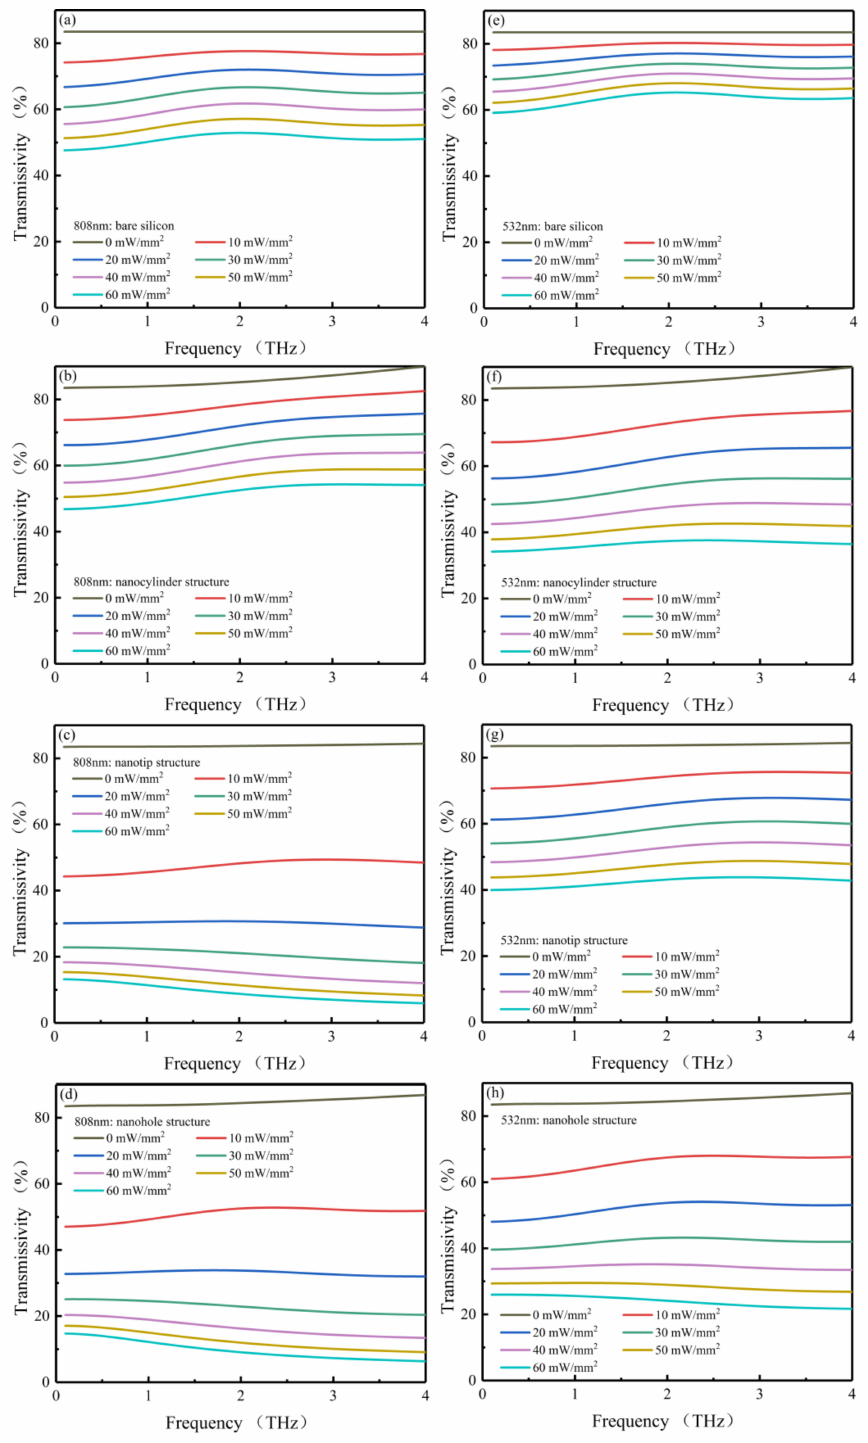
Figure 4. The frequency-resolved transmissivity values (0.1~4 THz) of bare silicon, nanocylinder, nanotip, and nanohole structures with 808 ( a – d ) and 532 nm ( e – h ) pump beams,